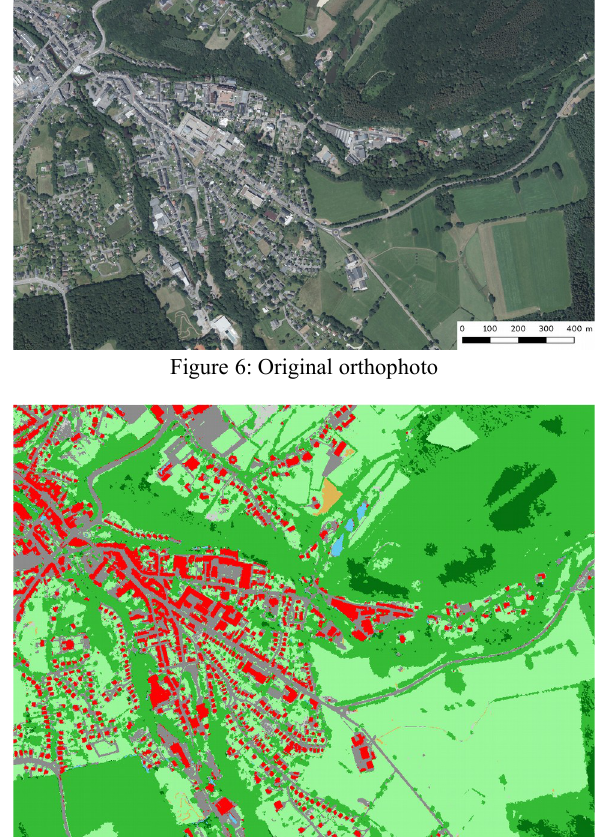
Figure 7: Object-based fusion using machine learning (for legend see figure 1)